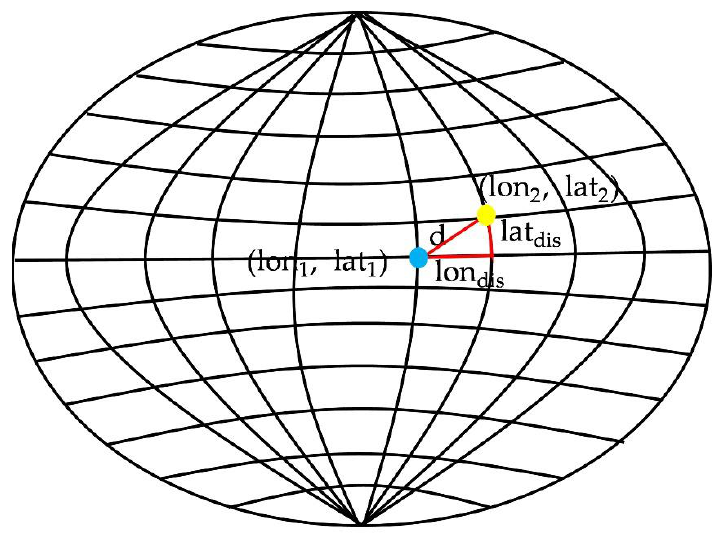
Figure 1. Typhoon moving angle diagram.